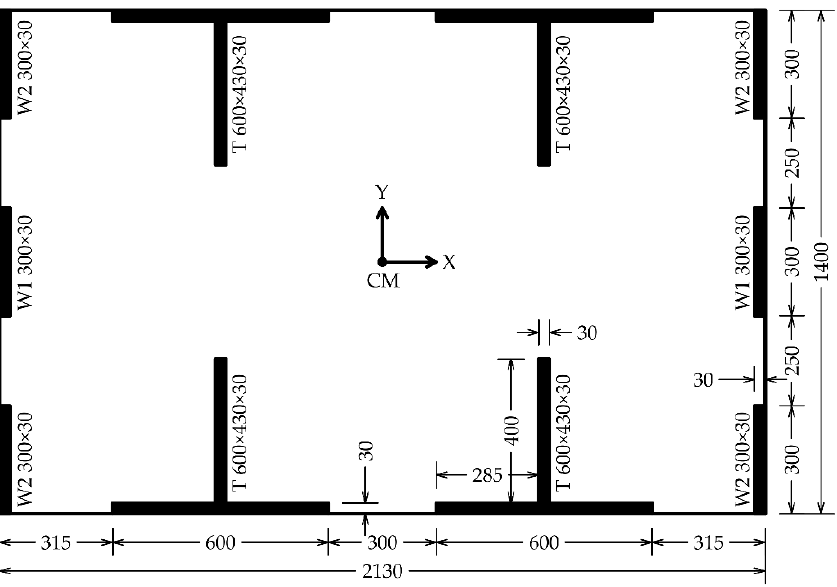
Figure 1. Plan of the considered twelve-storey RC building (dimensions in